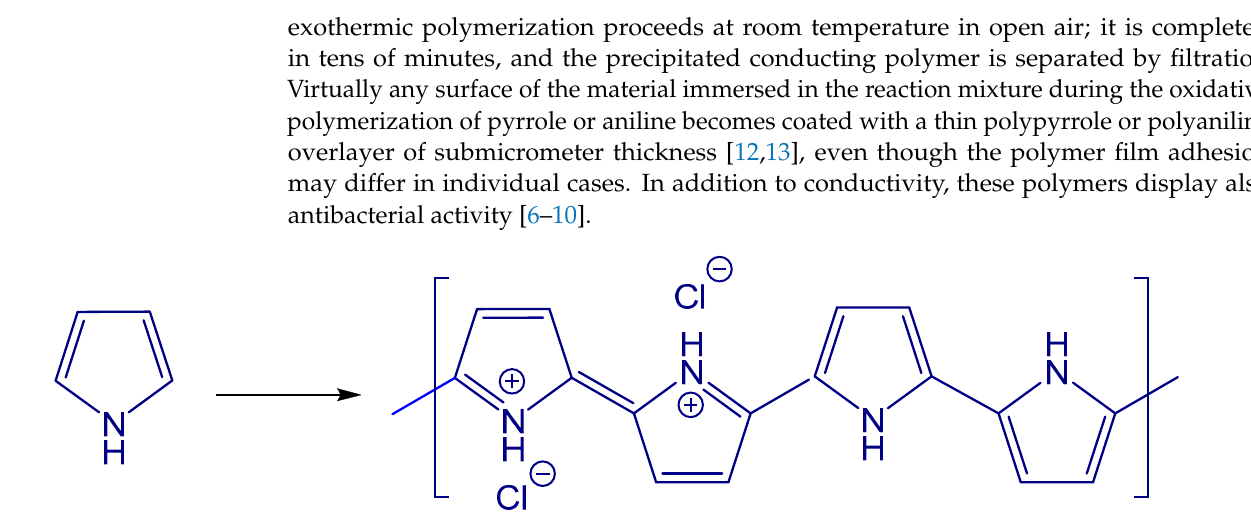
Figure 1. Oxidation of pyrrole with iron(III) chloride yields polypyrrole with chloride counter-ions.